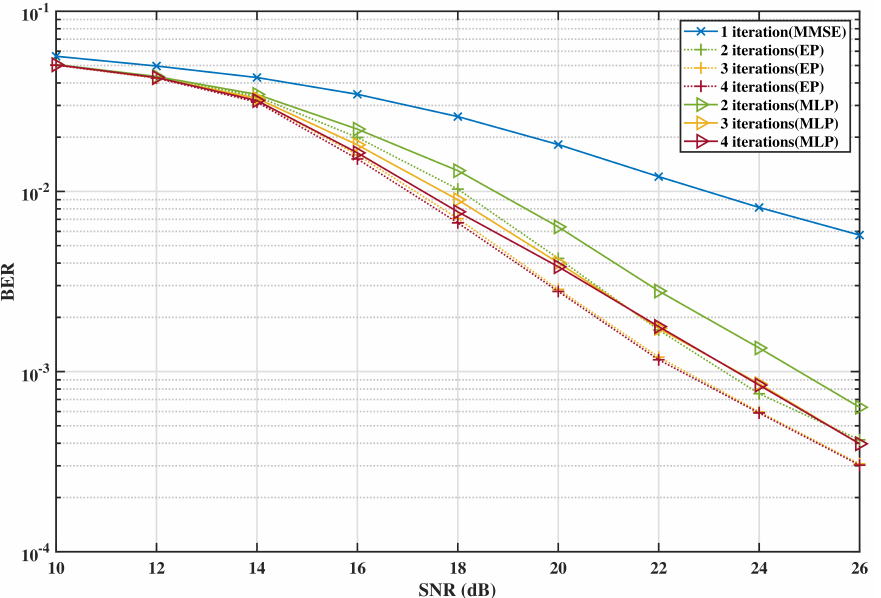
Figure 2. BER performance for the case of the Rayleigh fading MIMO channel scenarios with n = 8, m = 8, and 64-QAM